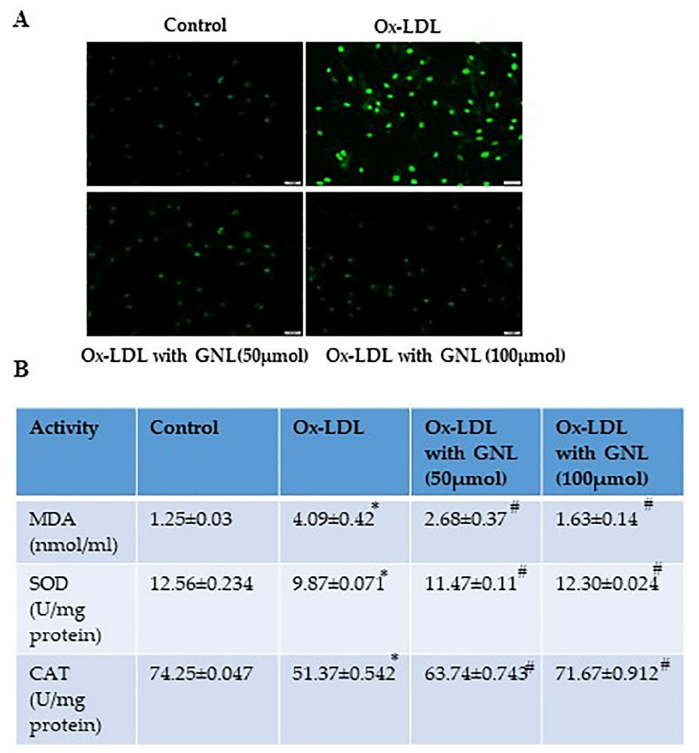
Figure 5. Effect of GNL on Ox-LDL-induced ROS production in HUVECs. ( A ) The HUVECs